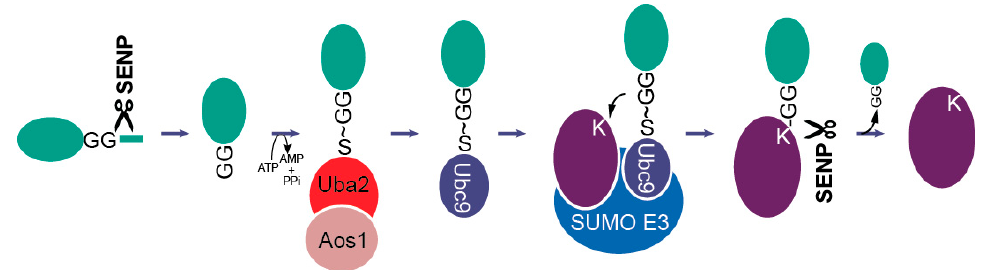
Figure 1. The SUMO pathway [13,18,19]. Similar to ubiquitylation, the SUMO conjugation pathway leads to formation of an isopeptide bond between the C-terminal carboxyl of the 11kDa protein SUMO and an ε -lysine of the target protein. SUMO precursors are first processed by SUMO isopeptidases, leaving a C-terminal di-glycine (GG) motif that is activated in an ATP-dependent manner, forming a thioester with catalytic cysteine of the heterodimeric E1-activating enzyme Uba2/Aos1. Next, SUMO is transferred onto the catalytic cysteine of the E2-conjugating enzyme (Ubc9) and finally onto the target protein, either directly or through a SUMO E3 ligase. SUMO itself can also serve as target for SUMOylation, leading to formation of polySUMO chains. SUMOylation is reversed by one of the SUMO isopeptidases that processed its precursor in the first step (SENP1-3 and SENP5-7 in human and Ulp1 and 2 in budding yeast). SENP1, 2, 3, and 5 belong to the Ulp1 branch, whereas SENP6 and 7 are more closely related to the Smt4/Ulp2 branch [20]. Contrary to ubiquitylation, SUMOylation does not always require a E3 ligase, at least in vitro [21]. Nevertheless, three classes of E3 ligases are the best characterized (for a review, see [22]; other types of SUMO E3s also exist). The SP-RING family was identified with Siz1/Siz2 in budding yeast